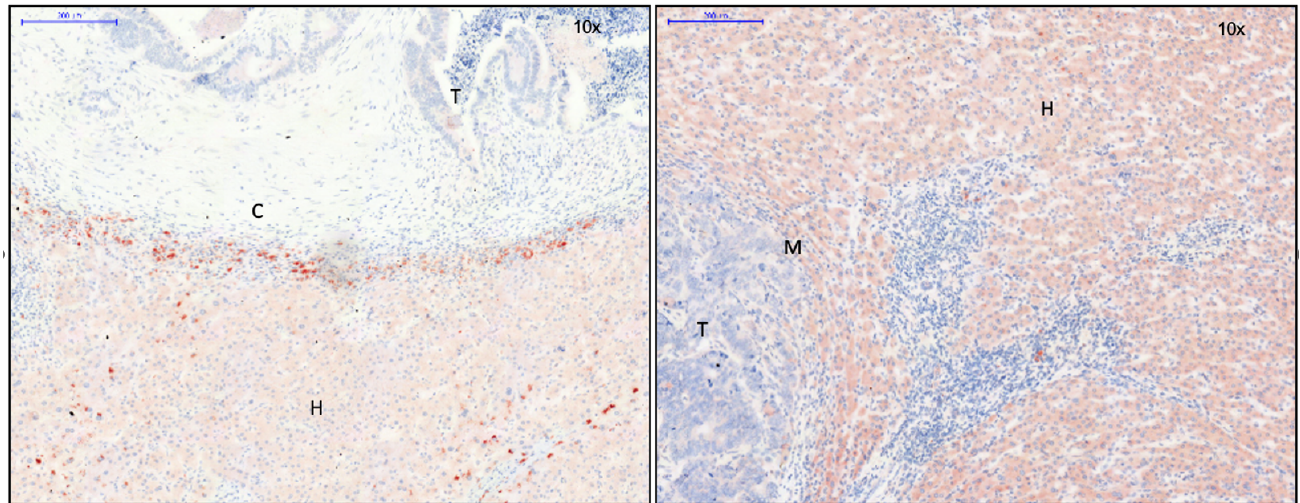
Figure 6. Left: capsule; right: no capsule. Tomoregulin-1, 10 × magnification. Expression of tomoregulin-1 in liver cells near the tumor margin in CRLM with capsule. There was no evidence of tomoregulin-1 in CRLM without capsule. Legend: T, tumor; H, hepatocytes; M, tumor margin; C,